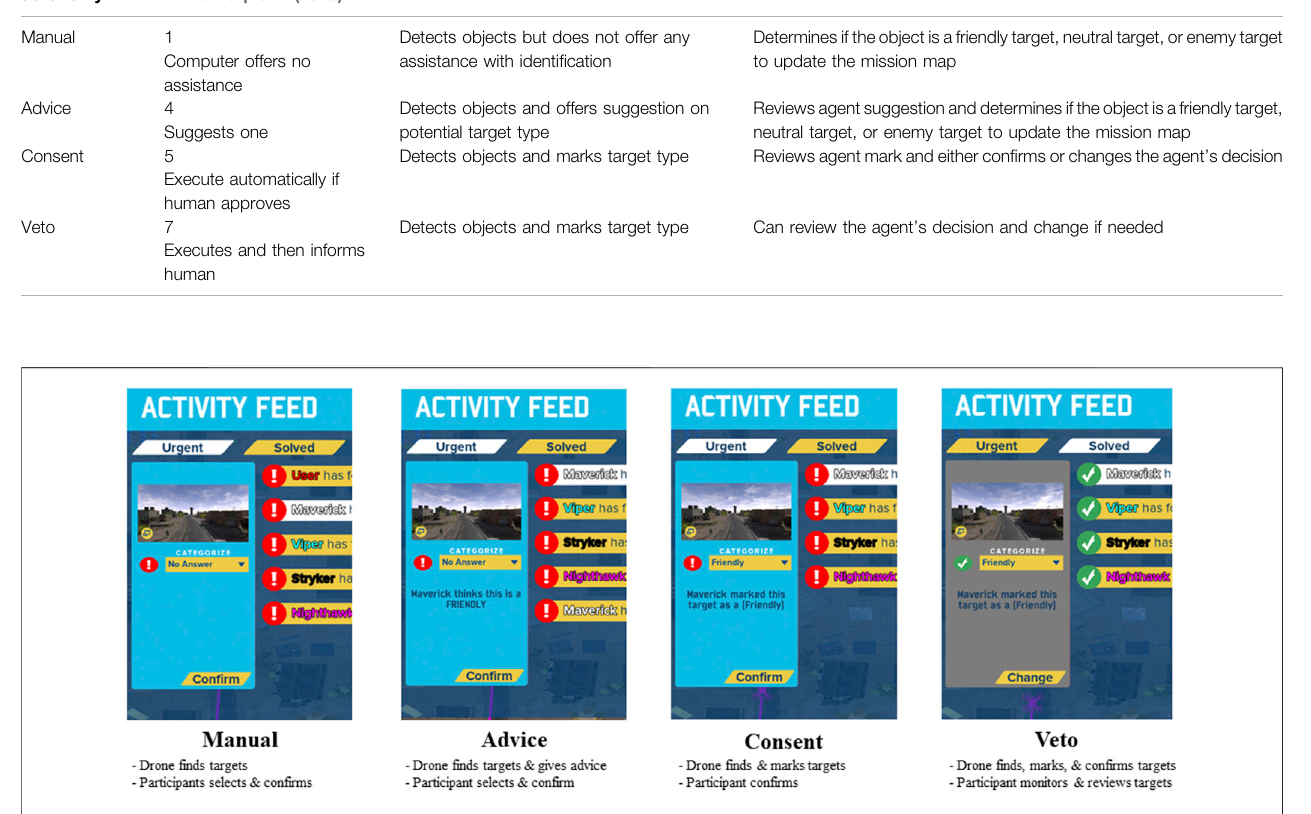
FIGURE 1 | Experimental